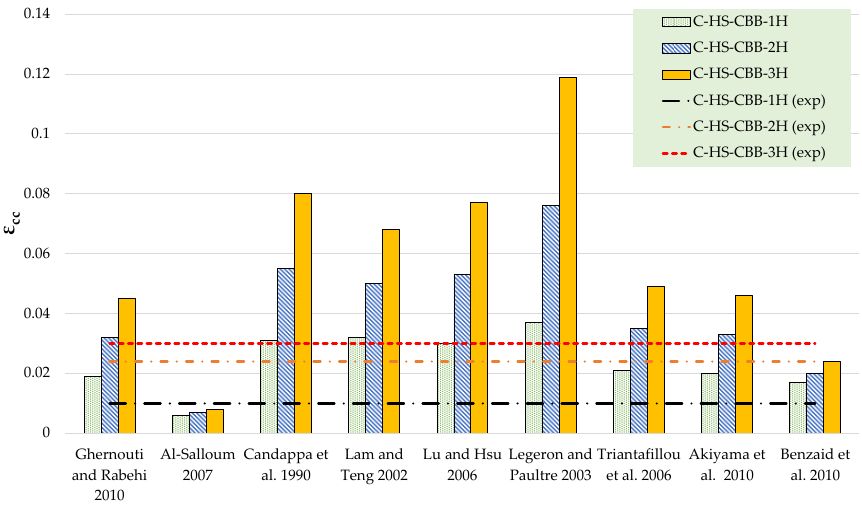
Figure 15. Comparison of strain for Type-2 group [31 – 39].